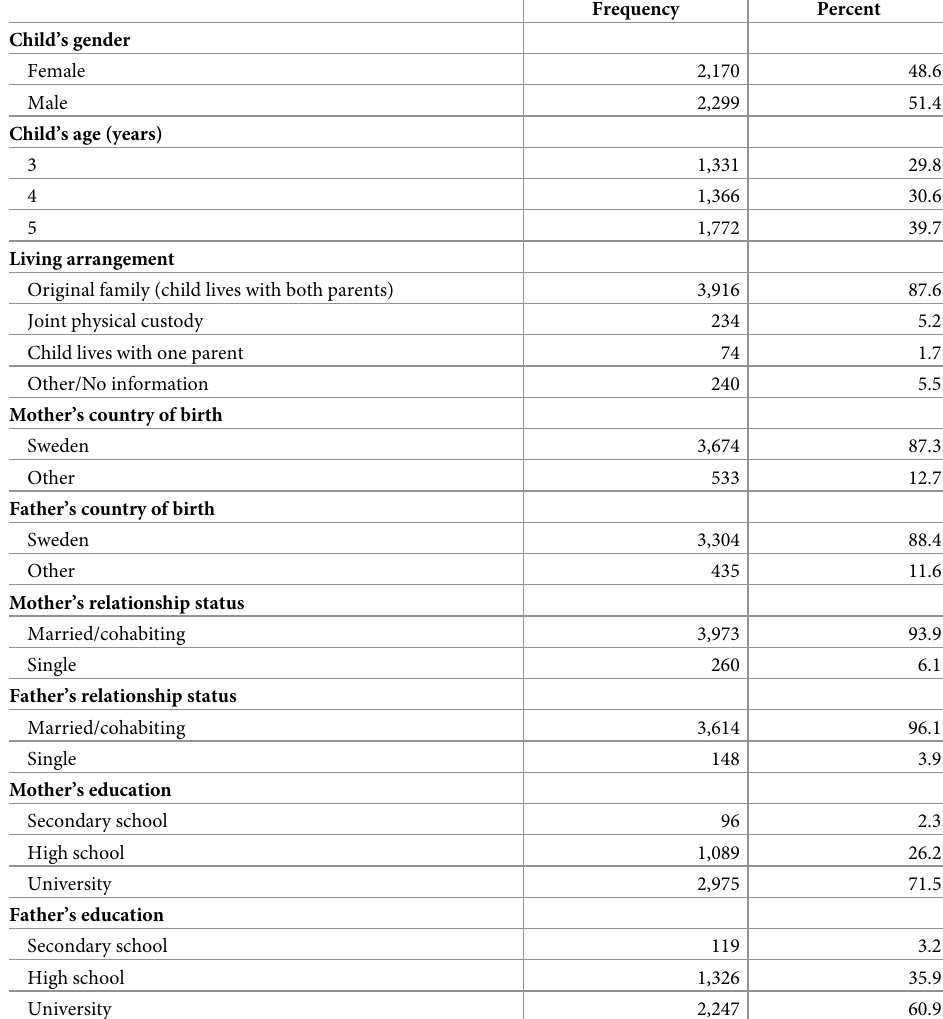
Table 1. Socio-demographic characteristics of the participating children and parents (n =